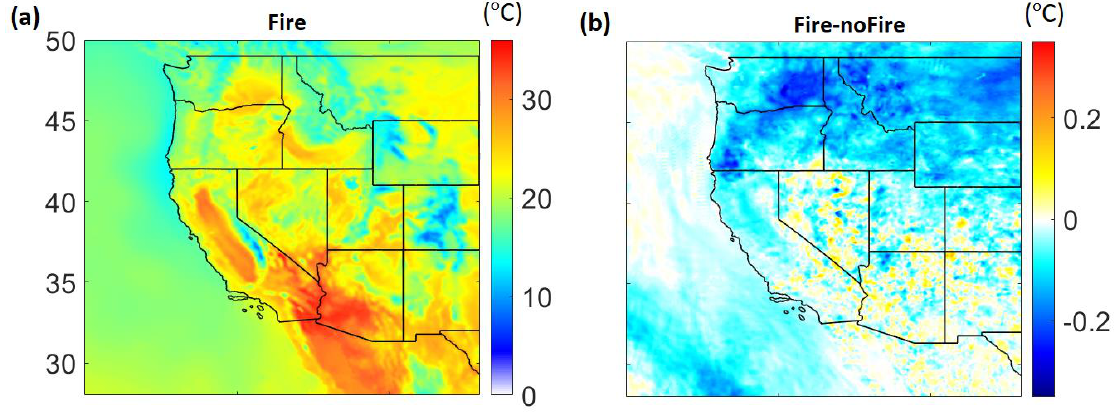
Figure 8. Spatial distribution of ( a ) average 2 m temperature in ◦ C for ‘Fire’ simulation, ( b ) average difference between ‘Fire’ and ‘noFire’ simulations in ◦ C, for the first half of September 2017.